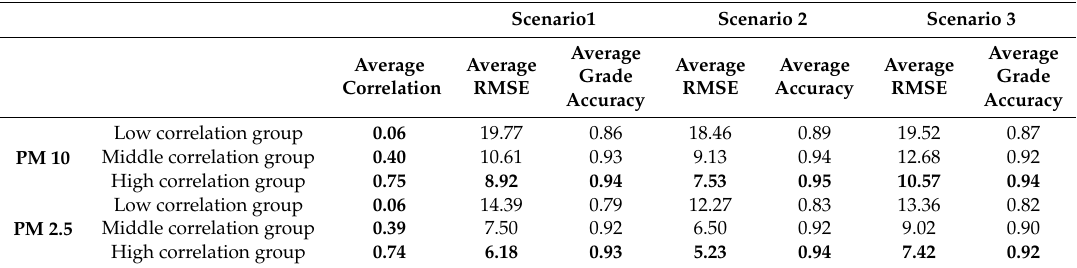
Table 6. PM10 and PM2.5 prediction results based on the correlation